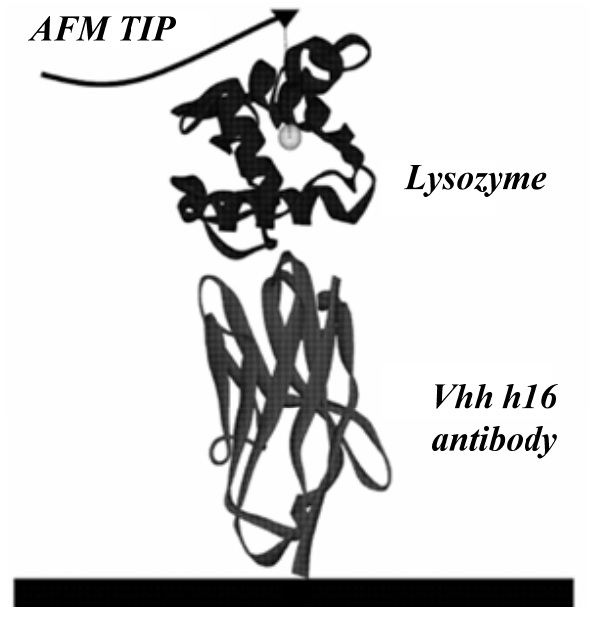
Figure 1. Schematic model of the steered molecular dynamics